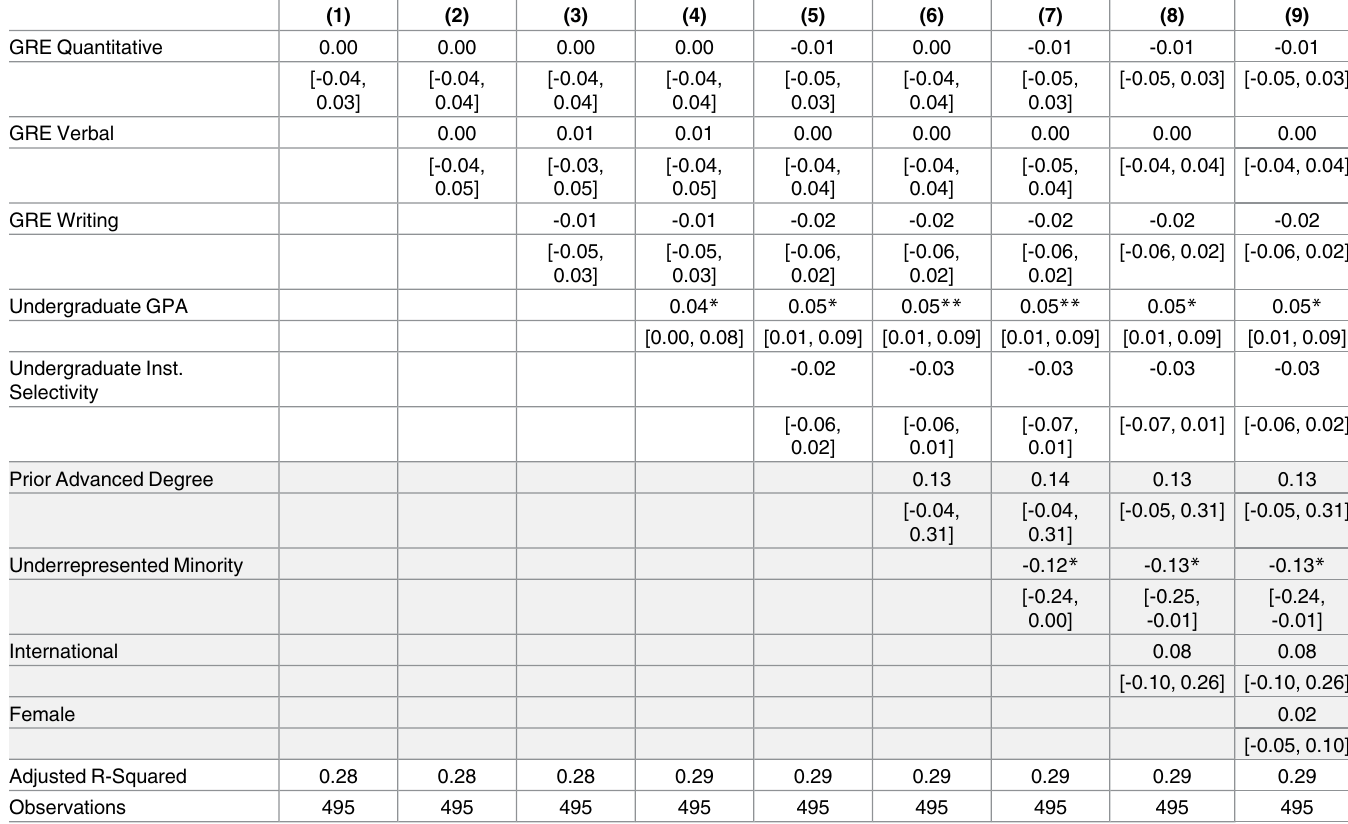
Table 2. The predictive power of GRE scores and other admissions criteria on Graduation with a Ph.D.